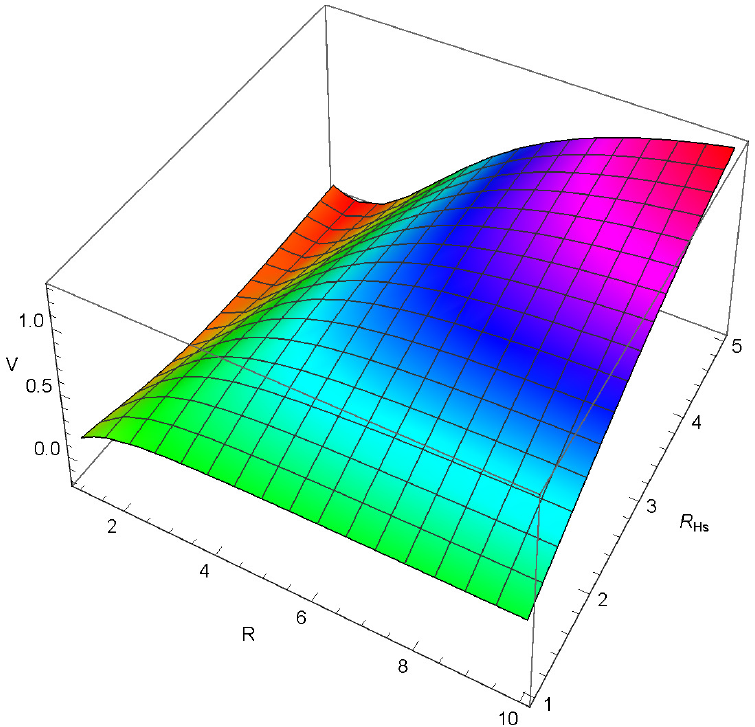
Figure 22. Solution of V ( φ 2 ) for p = 2. The evolution of V ( φ 2 ) is obtained using Equations (32) and (42).